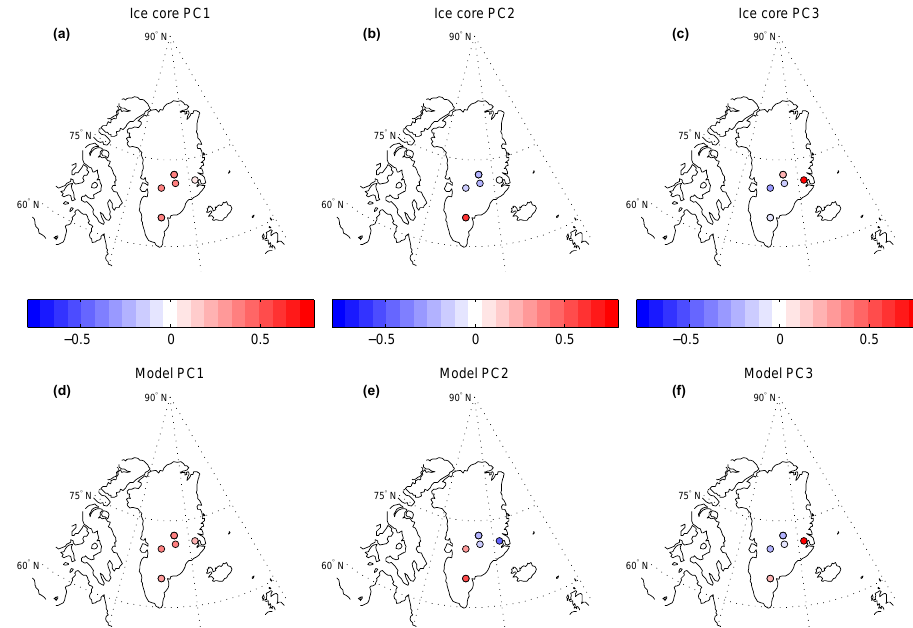
Figure 1. Spatial patterns of the three main modes of variability in the δ 18 O ice core records used in this study and the modeled modes of variability at these sites. The pattern of the loadings on ice core δ 18 O PCs are shown in (a, b, c) and modeled loadings on δ 18 O PCs at the ice core sites are shown in (d, e, f)